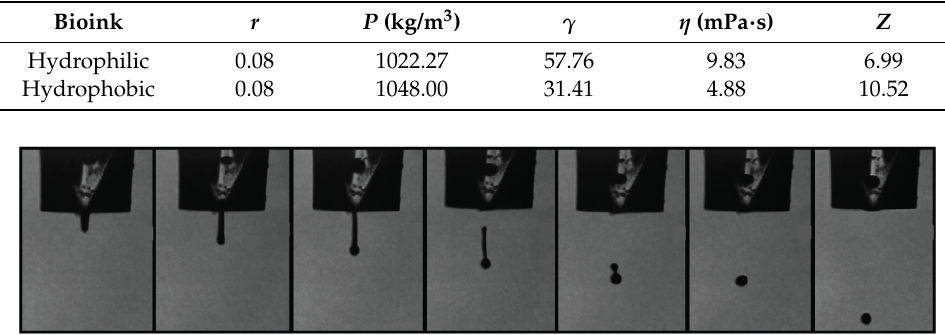
Figure 4. Droplet formation sequence for hyaluronic acid-based bioink with a W PEGDA of 3%, a r ratio of 0.6, and loaded with lisinopril at a concentration of 40 mg/mL. This formulation had a Z value of 6.99, falling within the printable range (4–14).